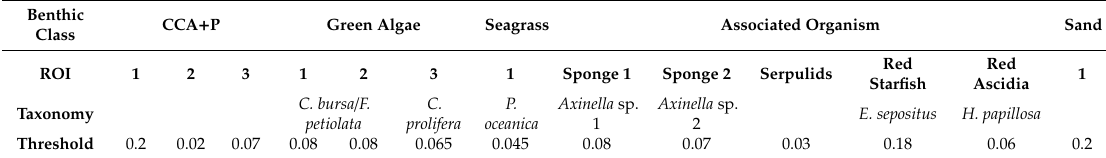
Table 2. Selected ROIs for the benthic classes of the coralligenous site and relative threshold values used in the ‘Rule classifier’